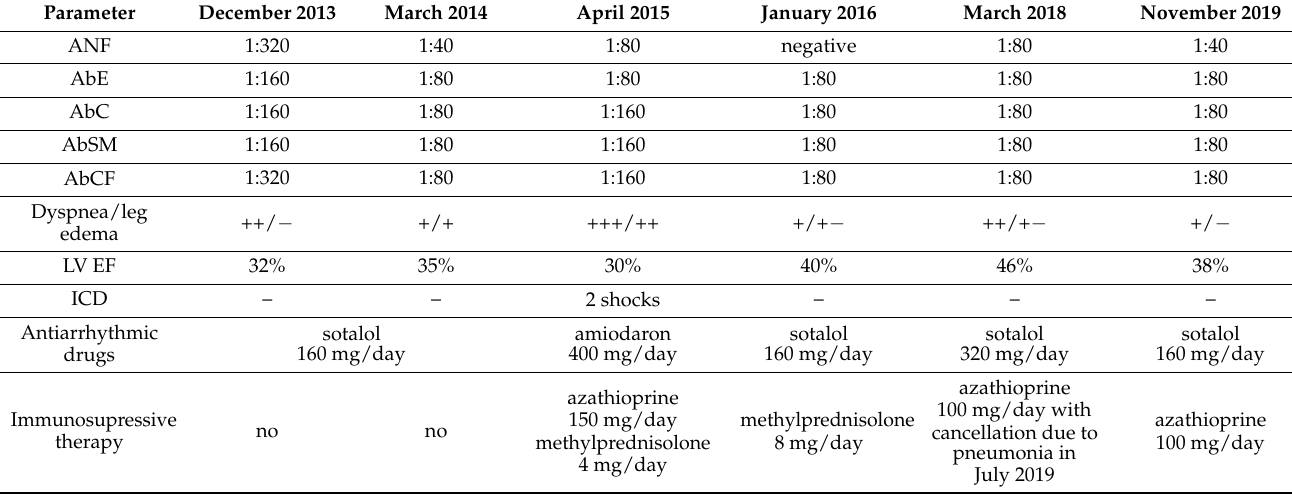
Table 1. Follow-up of patient